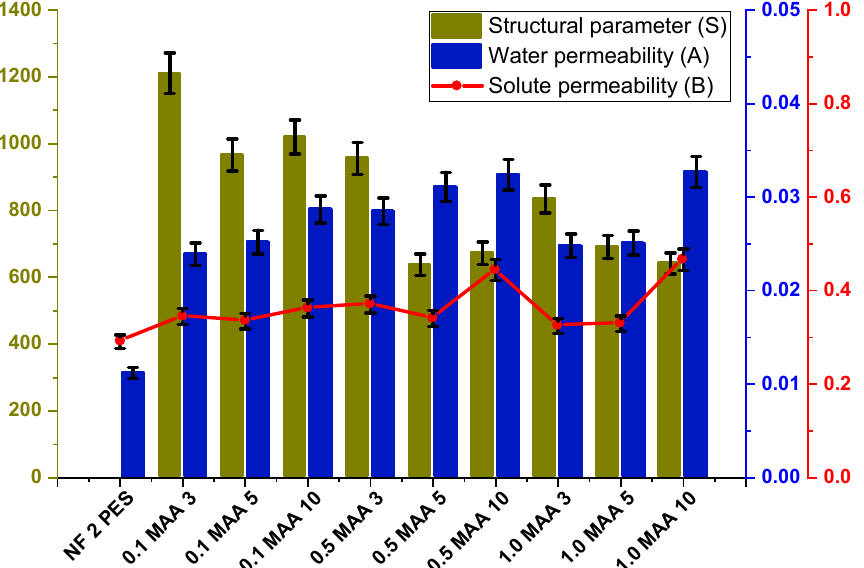
Figure 14. Structural parameter (S), water permeability (A) and salt permeability (B) of the UV − grafted membranes.